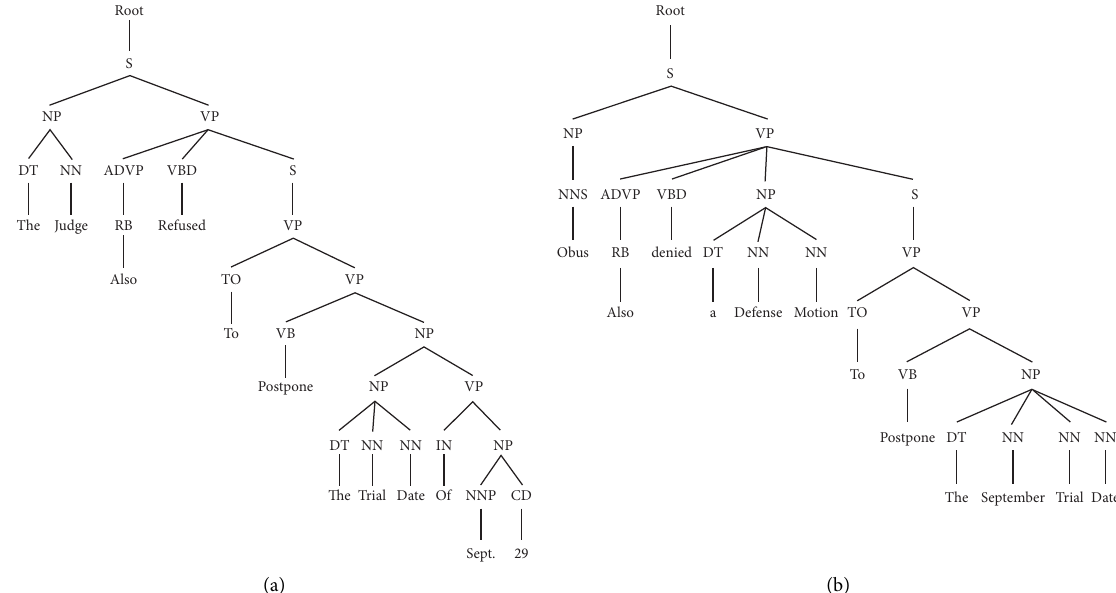
Figure 5: Paraphrase sentence pair-different words with different syntax structure. (a) S Sept. 29. (b) S 2 : Obus also denied a defense motion to postpone the September trial date.